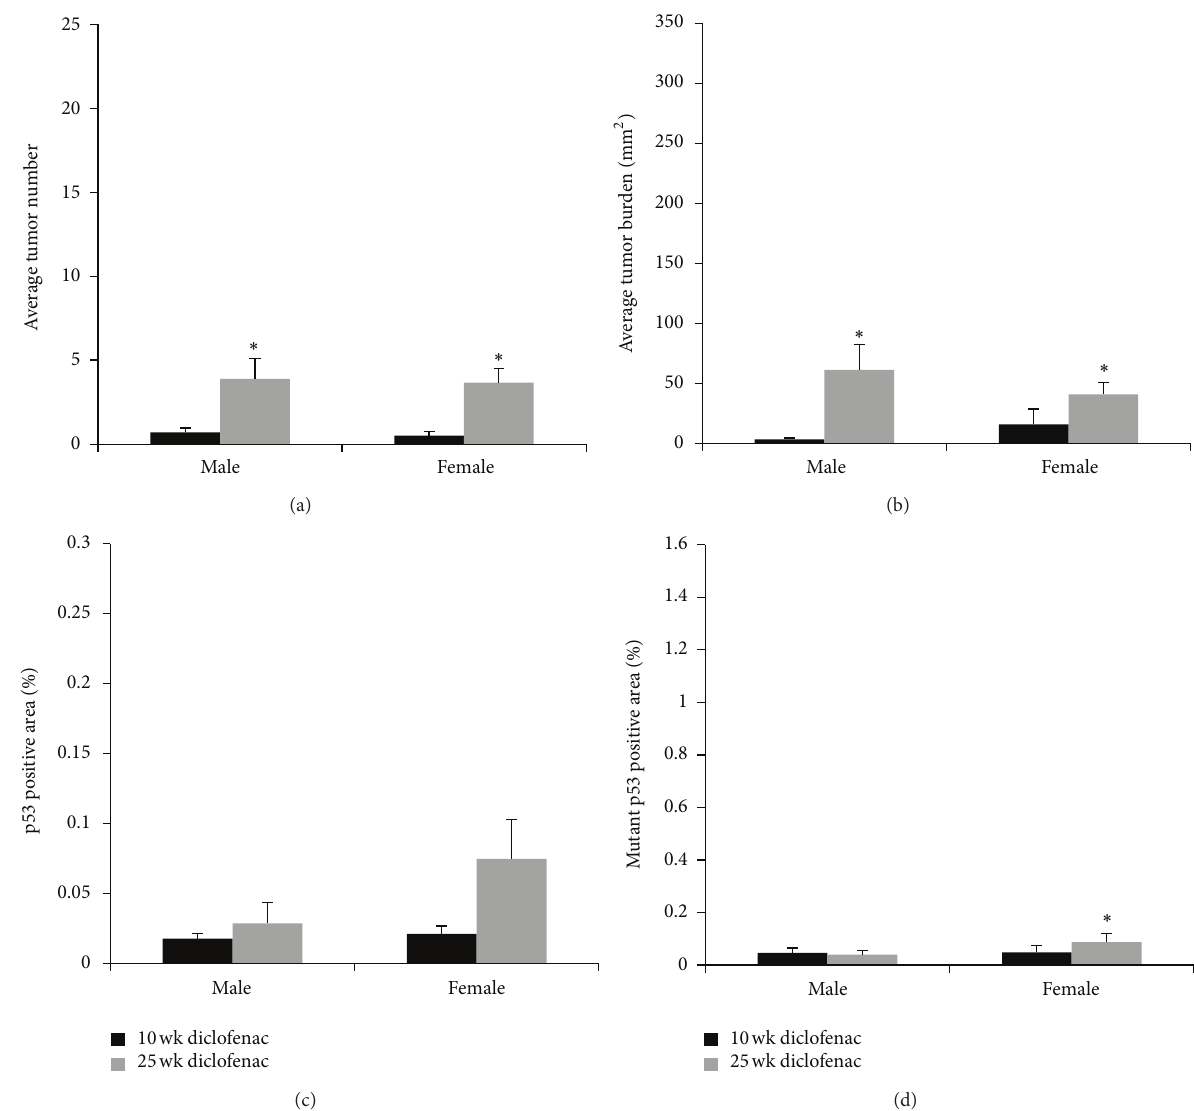
Figure 2: Efficacy of diclofenac on tumor number, burden, and p53 status in male and female mice. (a) Male and female diclofenac treated mice developed significantly more tumors in the 25- compared to the 10-week model ( ∗ 𝑃 < 0.0001 ). (b) Male ( ∗ 𝑃 < 0.0001 ) and female ( ∗ 𝑃 = 0.0005 ) diclofenac-treated mice in the 25-week UVB model developed significantly larger tumor burden compared to mice in the 10- week model. (c) Male and female mice treated with diclofenac in the 25-week exposure model did not exhibit significantly altered epidermal p53-positive area compared to the 10-week exposure model. (d) Female mice treated with diclofenac exhibited increased epidermal mutant p53-positive area ( ∗ 𝑃 = 0.0060 ) in the 25- compared to the 10-week model. Error bars = mean+/ − SEM.